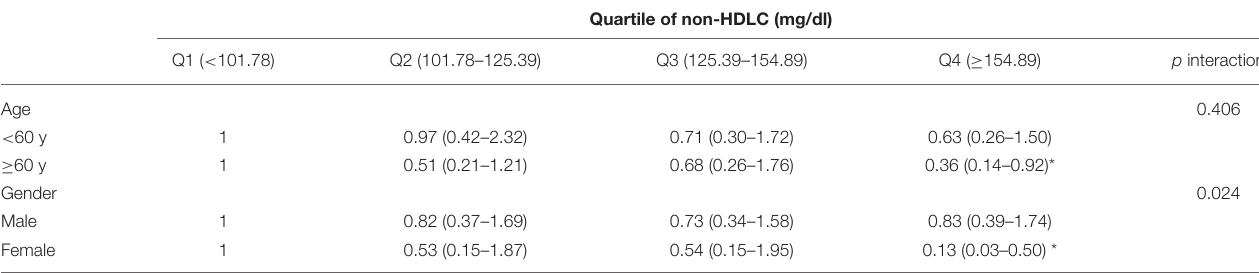
TABLE 3 | Multivariate-adjusted # OR and 95% CI for poor outcome (mRS ≥ 3) according to quartile of Non-HDLC, stratified by age, and gender.